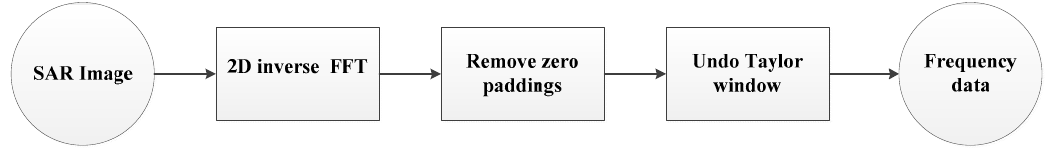
Figure 7. Procedure of transforming SAR images to the frequency domain. 2D: two-dimensional; FFT: fast Fourier transform.